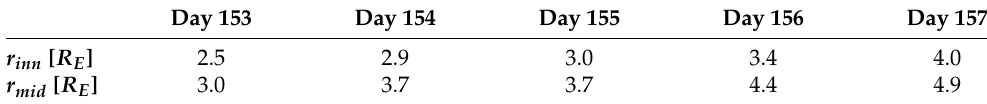
Table 1. Average PBL inner edge position in the interval 03:00–13:00 UT (05:00–15:00